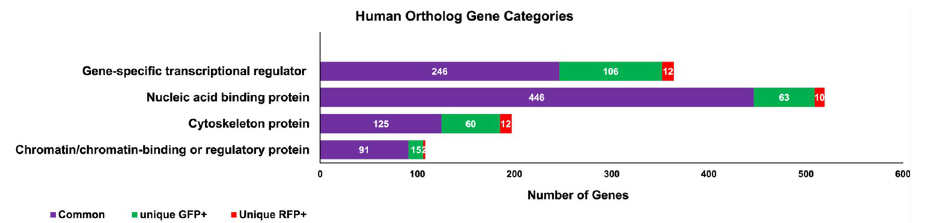
Fig 7. Different categories of human ortholog gene transcripts found in GFP+ and RFP+ thrombocytes. The raw data was used to obtain the list of zebrafish genes expressed in GFP+ thrombocytes and RFP+ thrombocytes using Ensembl and ZFIN databases. The list of human orthologs corresponding to zebrafish genes was also obtained using Ensembl and ZFIN databases. The list of these human orthologs were uploaded into the PANTHER program to obtain protein categories as well as to find human orthologs corresponding to unique and commonly expressed genes in GFP + and RFP+ thrombocytes. The bar graph represents the corresponding human orthologs of the unique RFP+ genes, unique GFP+ genes, and both RFP+ and GFP+ common genes shown in red, green, and purple colors, respectively. The number of human ortholog genes is shown in each bar, including their functional protein categories. The protein categories are gene-specific transcriptional regulators, nucleic acid-binding proteins, cytoskeleton proteins, and chromatin/chromatin-binding or regulatory proteins.